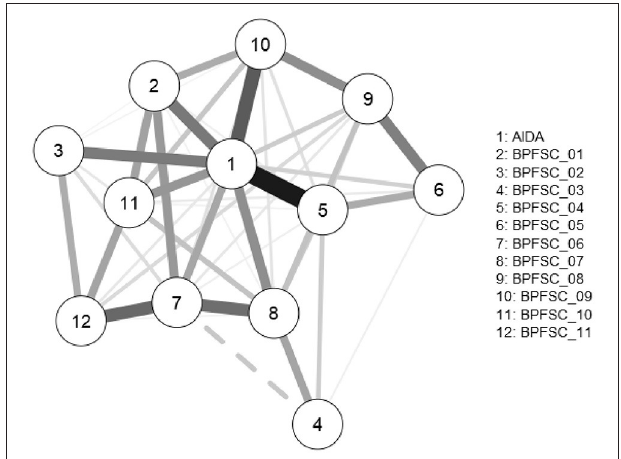
FIGURE 1 | The network of identity diffusion and borderline personality features.